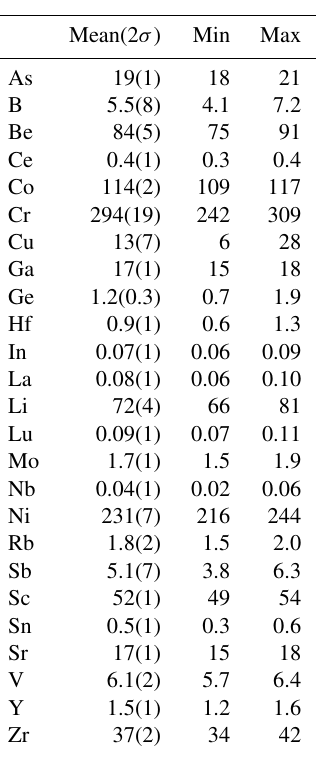
Table 2. Trace element composition of ferri-taramite (µgg − 1 ). Table 3. X-ray powder diffraction data ( d in Å) for